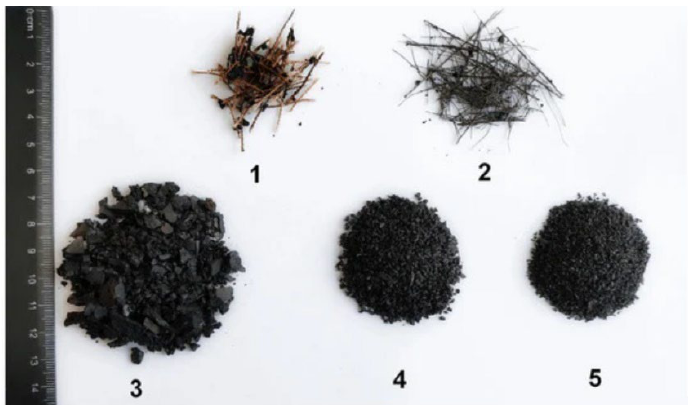
Figure 1. The different materials extracted from end-of-life tires such as (1) textile fiber, (2) metal cord, (3) large size fraction of rubber crumb (1–5 mm), (4) mean size fraction (1–2 mm), and (5) small size fraction (0.1–1 mm) [15].